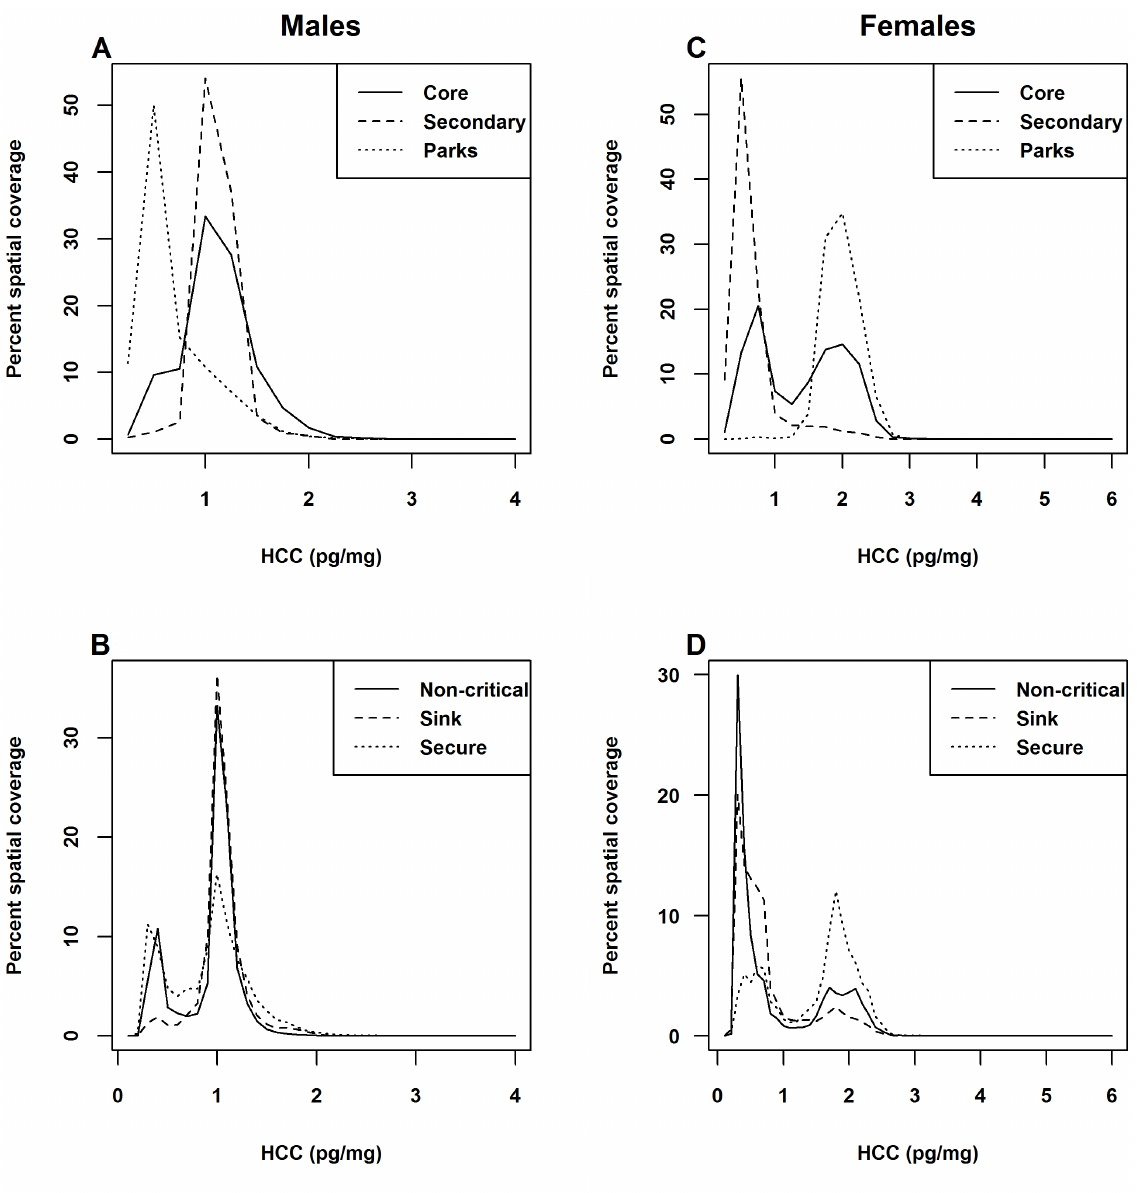
Figure 4. Frequency distributions of predicted HCC values associated with conservation management units and habitat states. Percent spatial coverage of predicted HCC values associated with (A – males; C – females) parks and protected areas, core conservation areas, and secondary conservation areas, as well as (B – males, D – females) secure, sink, and non-critical habitat states.